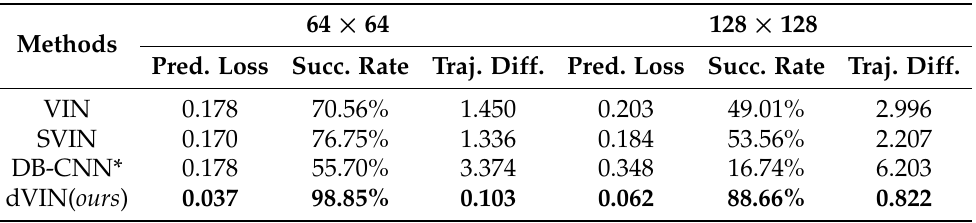
Table 3. Performance on 64 28 28 domains and then fine-tuned with a few large-size instances. ×